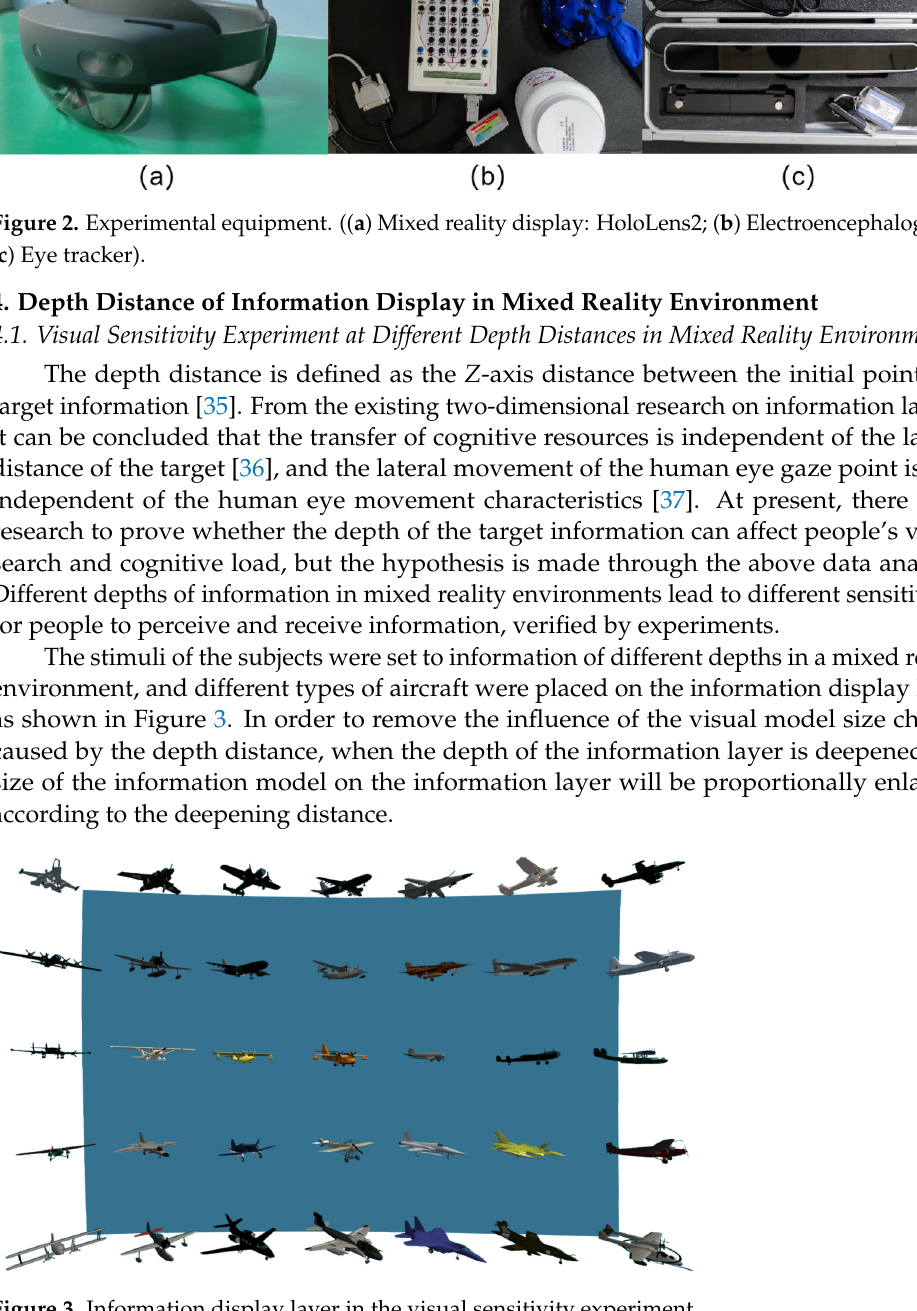
Figure 3. Information display layer in the visual sensitivity experiment.